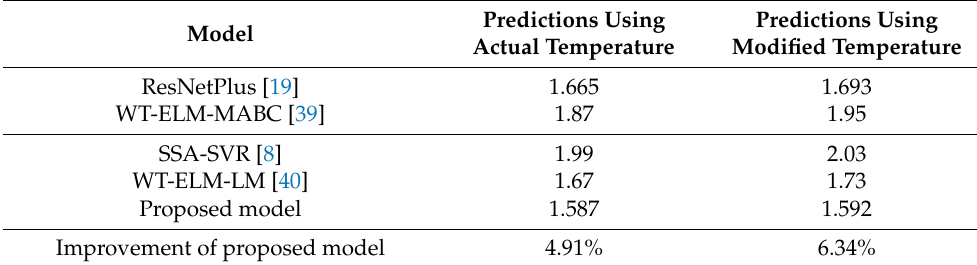
Table 6. Comparison to the existing methods—MAPE for load in the North American Utility data set.